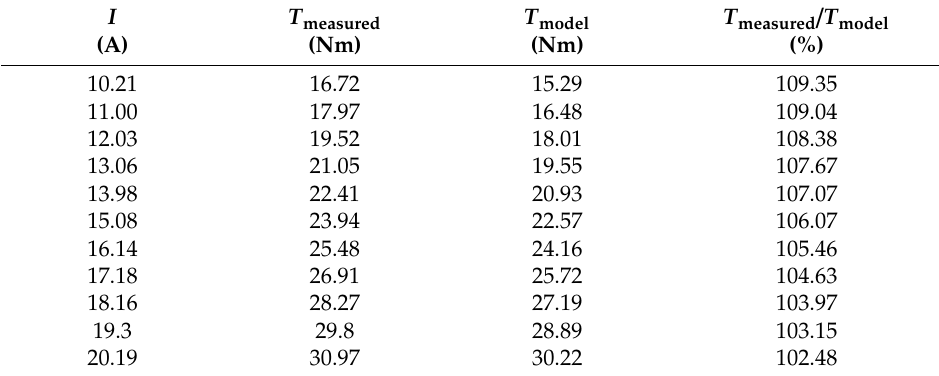
Table 9. Comparison of calculated and measured Torque at di ff erent electrical current values. I T measured T